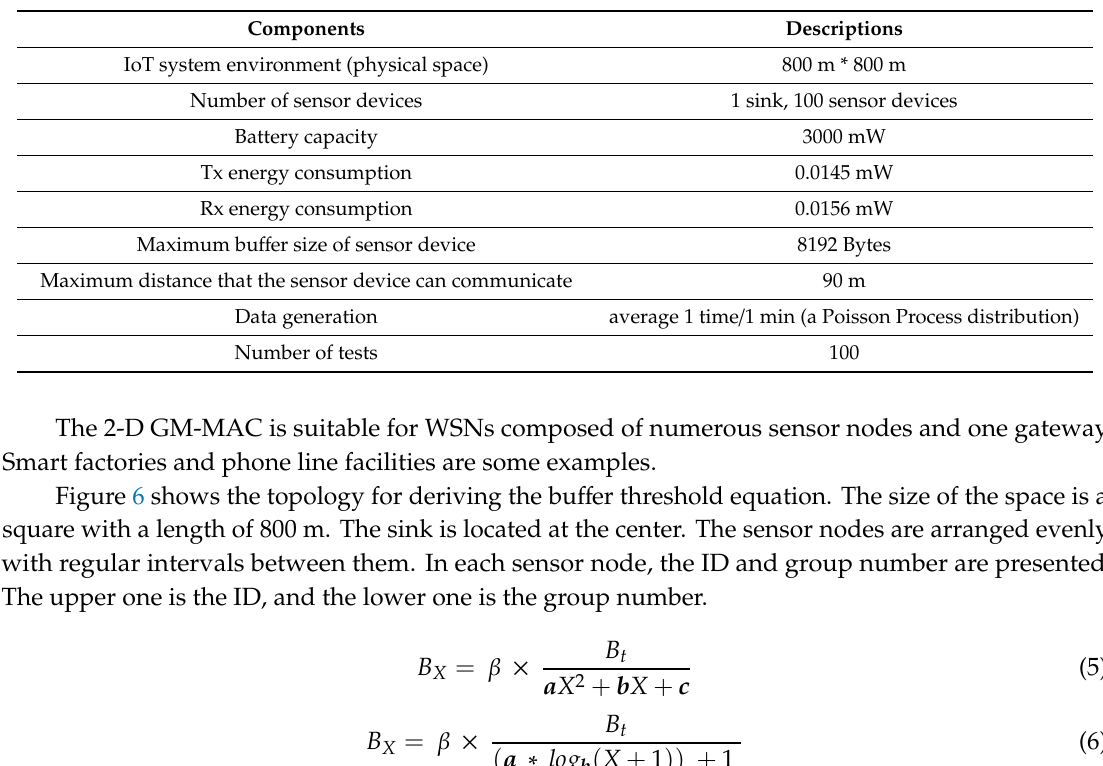
Table 1. Simulation details for deriving bu ff er threshold